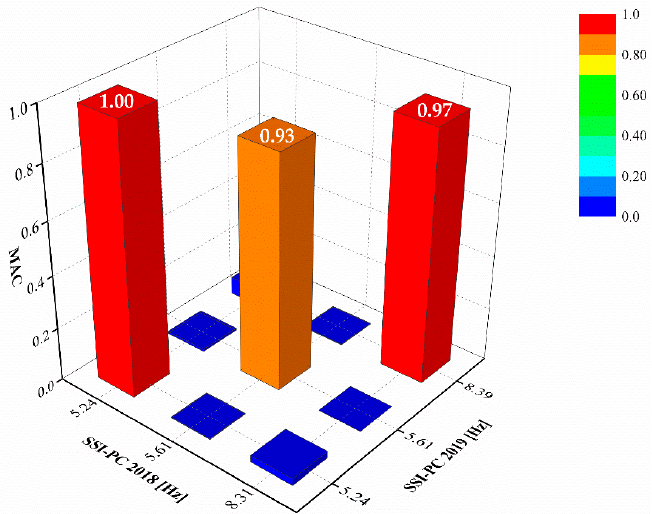
Figure 5. MAC between the modal vectors extracted by the 2018 and 2019 experimental campaigns with the SSI-PC